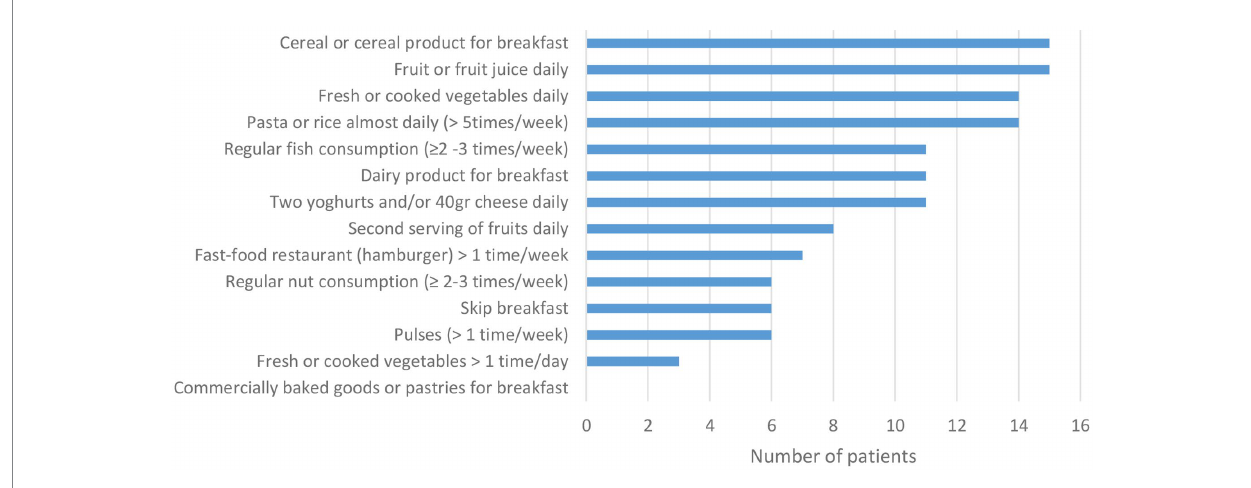
FIGURE 3 Number of patients with food habits corresponding to the separate index questions included in the Mediterranean Diet Quality Index (KIDMED), except for one missing question (use of olive oil). The numbers were based on the dietary interviews ( n =